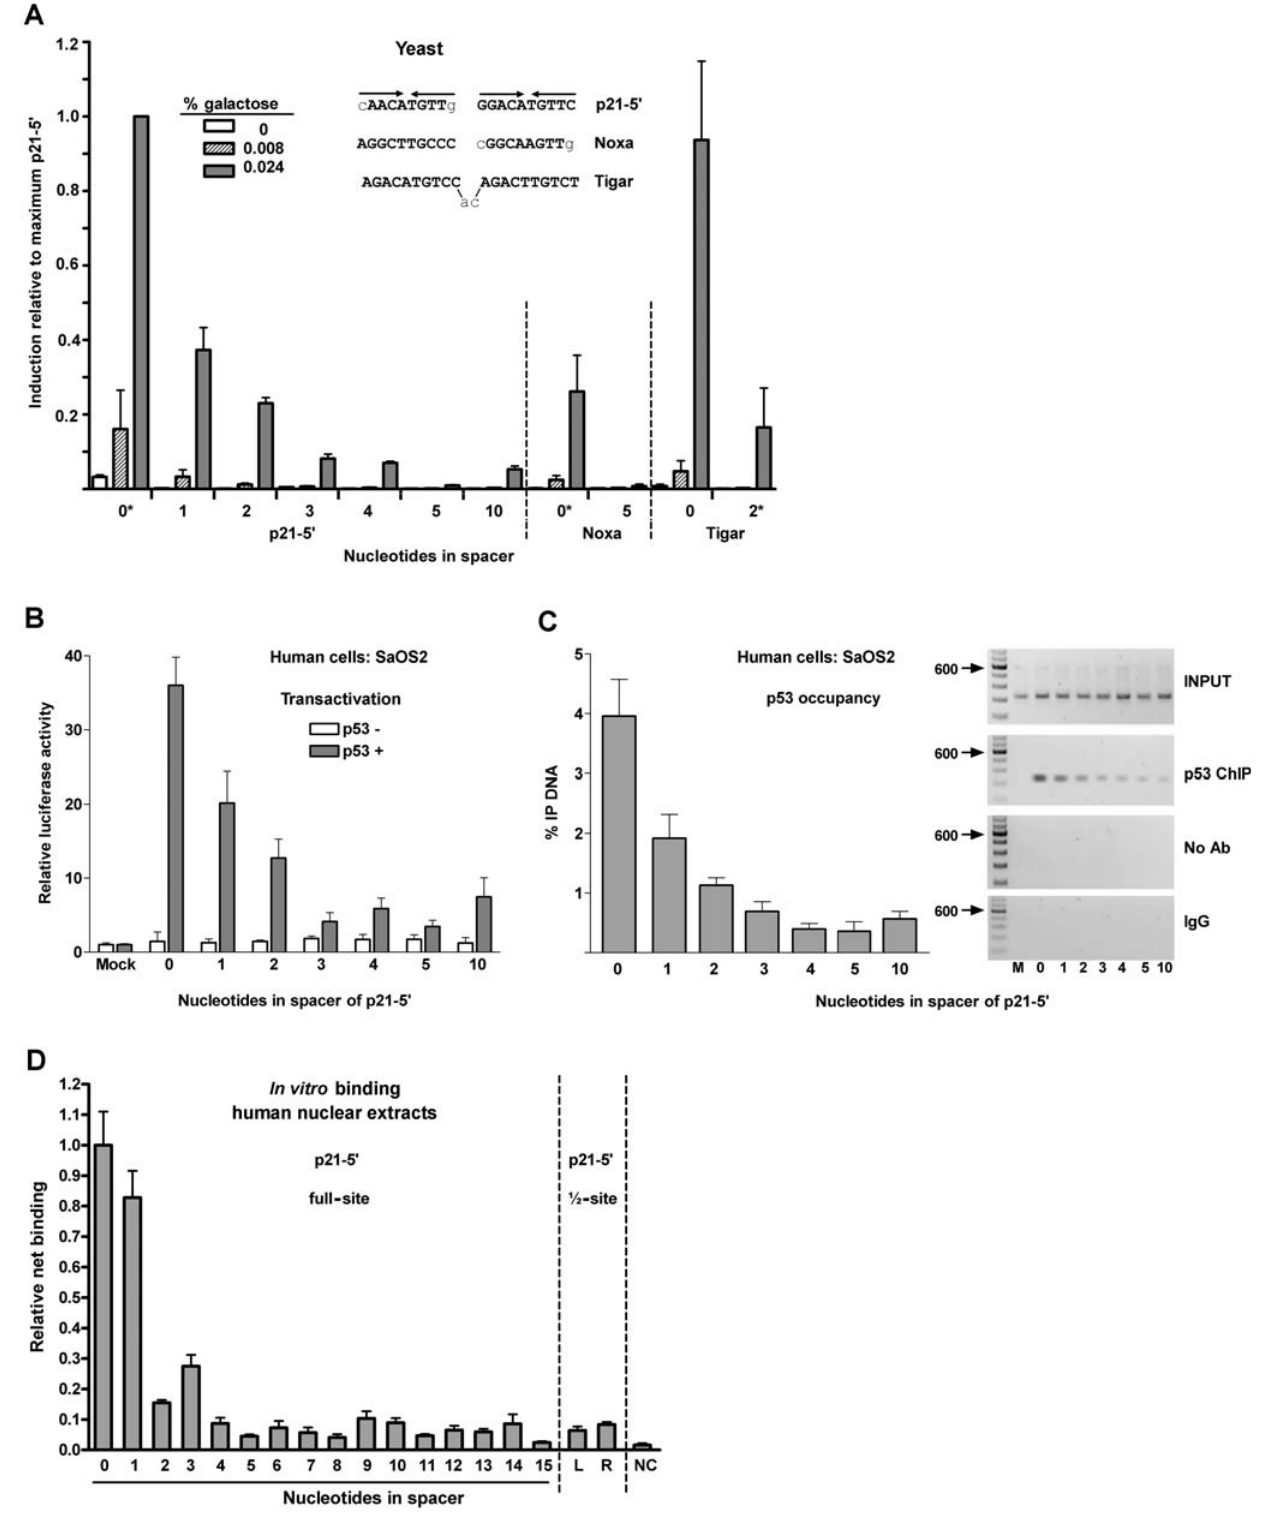
Figure 3. Spacer decreases p53 transactivation, promoter occupancy and binding in yeast and mammalian cells and invitro . (A) Transactivation in yeast. The ability of p53 to transactivate from REs containing spacers of variable nucleotide length sequences was measured 24 hours after p53 induction with a quantitative luciferase assay. Induction from each RE at various p53 expression levels were compared to the induction from the p21-5 9 RE at 0.024% galactose. The average light units/ m g protein for WT p53 towards p21-5 9 at 0.024% galactose for a minimum of 6 biological repeats was 1.26 million. *indicates the number of nucleotides in the spacer of the natural RE. Solid arrows identify a J -binding site. (B) Human SaOS2 cells were transfected with p21-5 9 ::luciferase reporter constructs containing spacers of increasing length between decamer half-